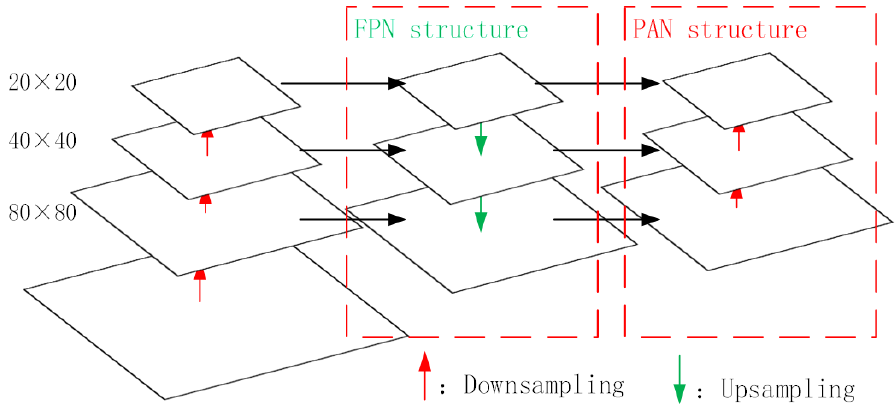
Figure 6. The structure of FPN and PAN.